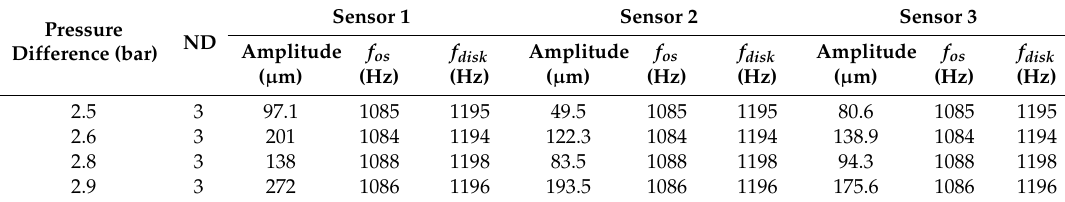
Table 8. Results for the second prototype at 1.5 × RPM nominal .